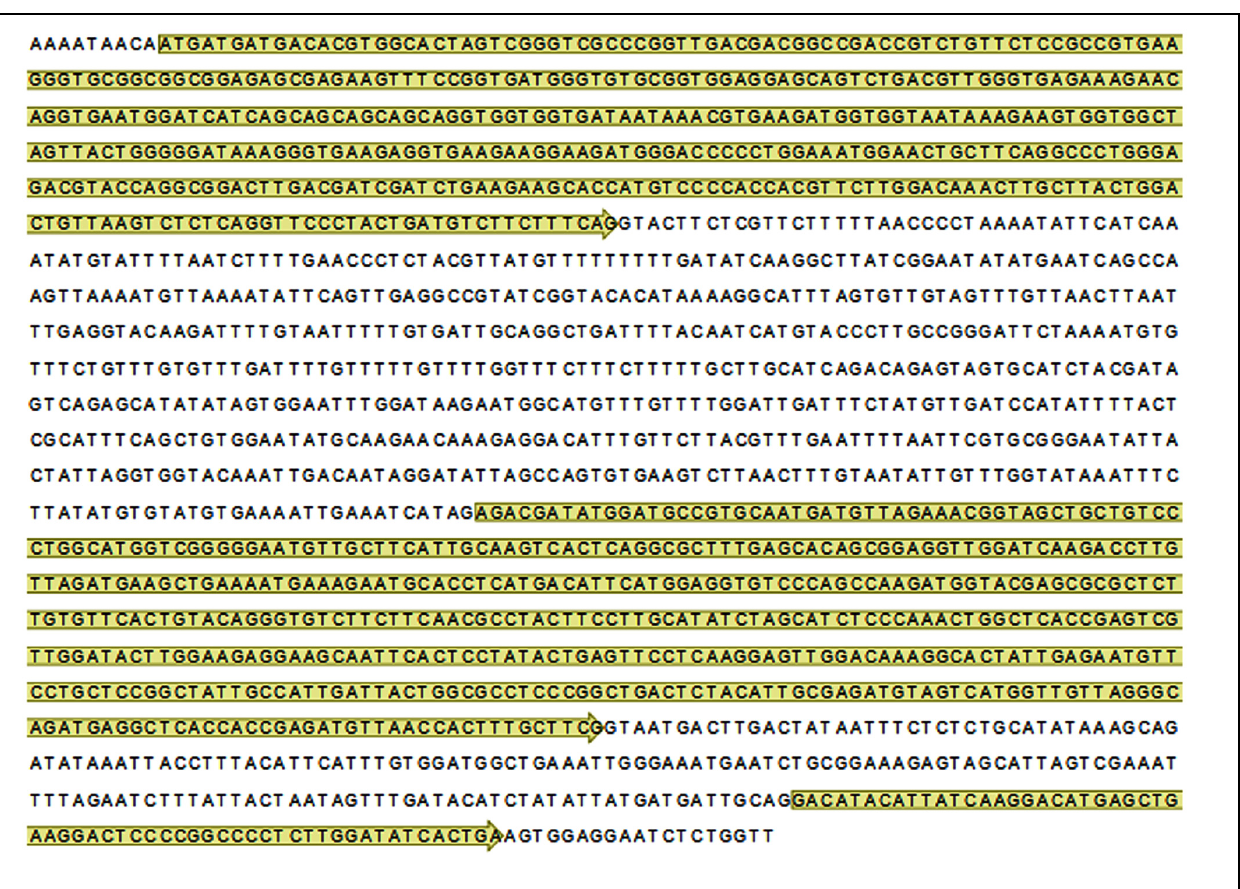
differentiation events and the role of associated stress